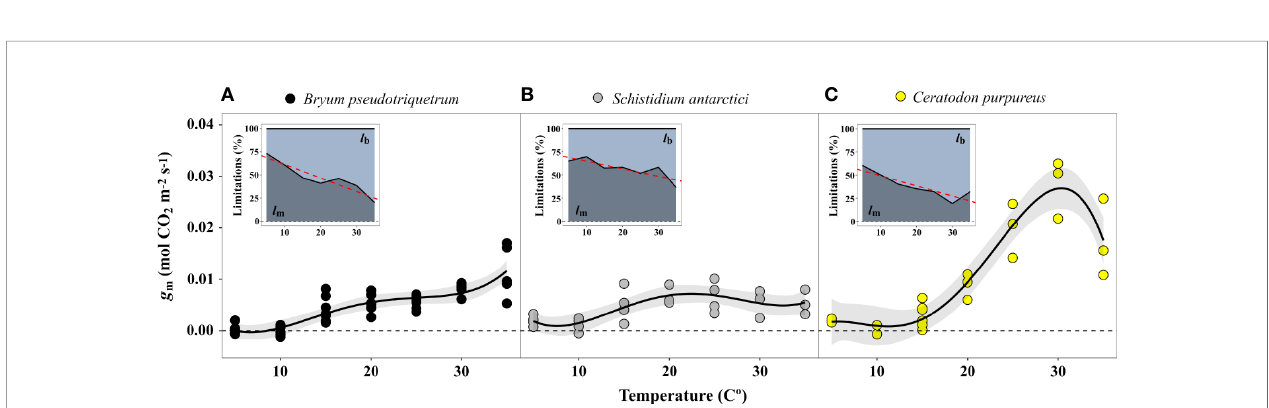
FIGURE 8 | Temperature response of mesophyll conductance ( g m ) of (A) B. pseudotriquetrum , (B) S. antarctici , and (C) C. purpureus . Lines represent quadratic polynomial fi ttings of g m with their respective 95% con fi dence intervals (shaded areas, n = 3 – 5). Inset graphs show the temperature relationship of the percentage of biochemical ( l b ) vs mesophyll limitations ( l m ) to photosynthesis. Linear regression of l m -temperature relation is represented by a red dashed line ( P <